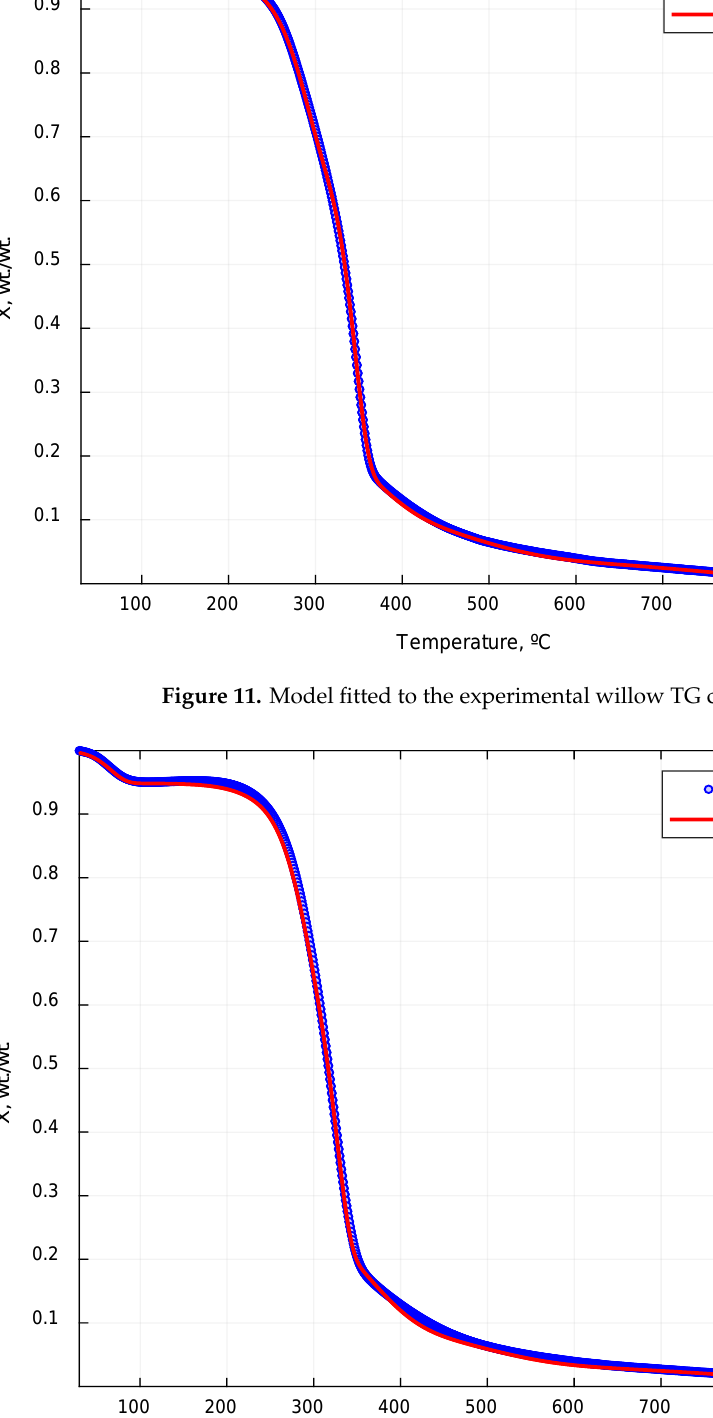
Figure 12. Model fitted to the experimental wheat straw TG curve.